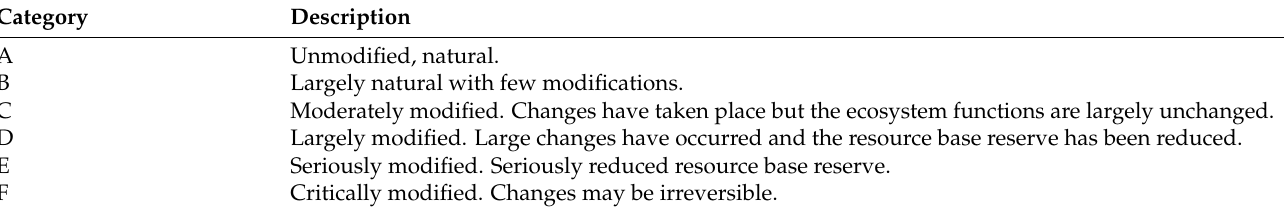
Table 1. Summary of the ecological categories used in determination of the present state and for the recommended ecological management